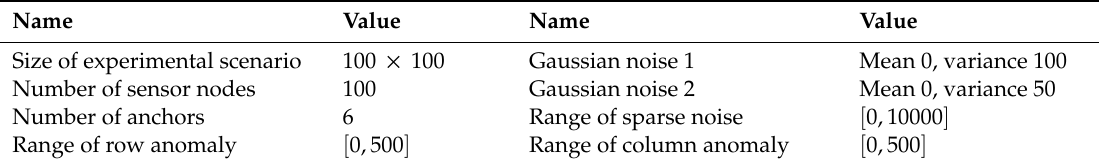
Table 1. Simulation